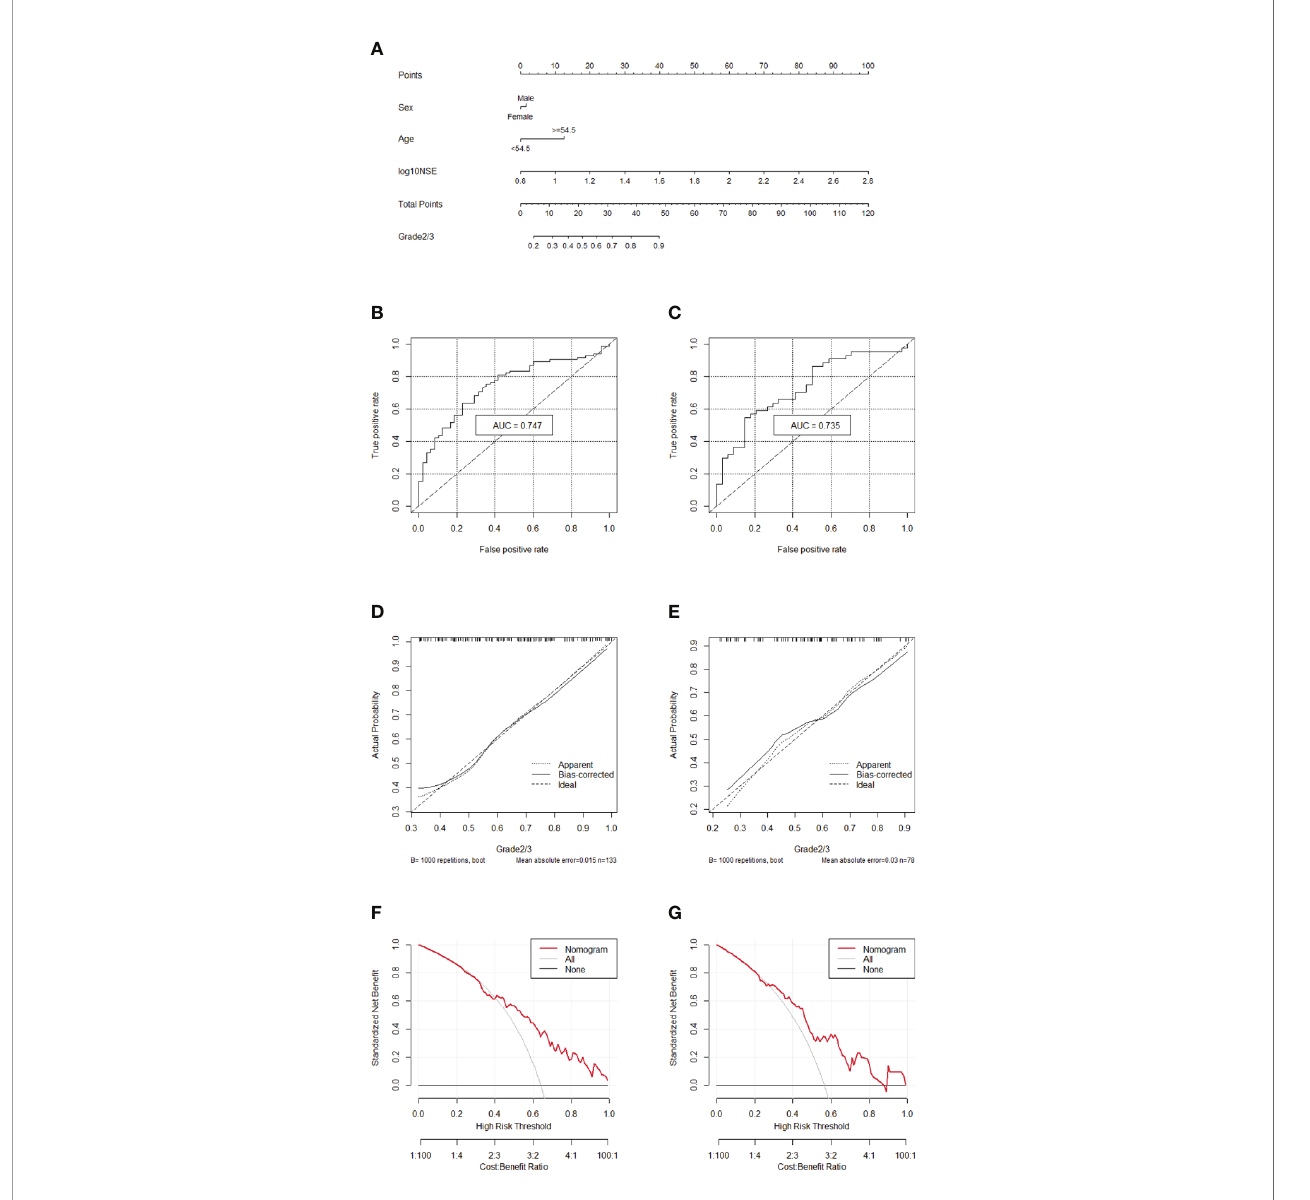
FIGURE 2 | Nomogram for preoperatively predicting of G2/3 risk and its predictive performance. (A) Nomogram to estimate the risk of G2/3 preoperatively in patients with GEP-NETs. The area under the ROC curve [training datset: (B) validation dataset: (C) , the calibration curve (training datset: (D) validation dataset: (E) ] and decision curve [trainingdata set: (F) validation dataset: (G) ] of the